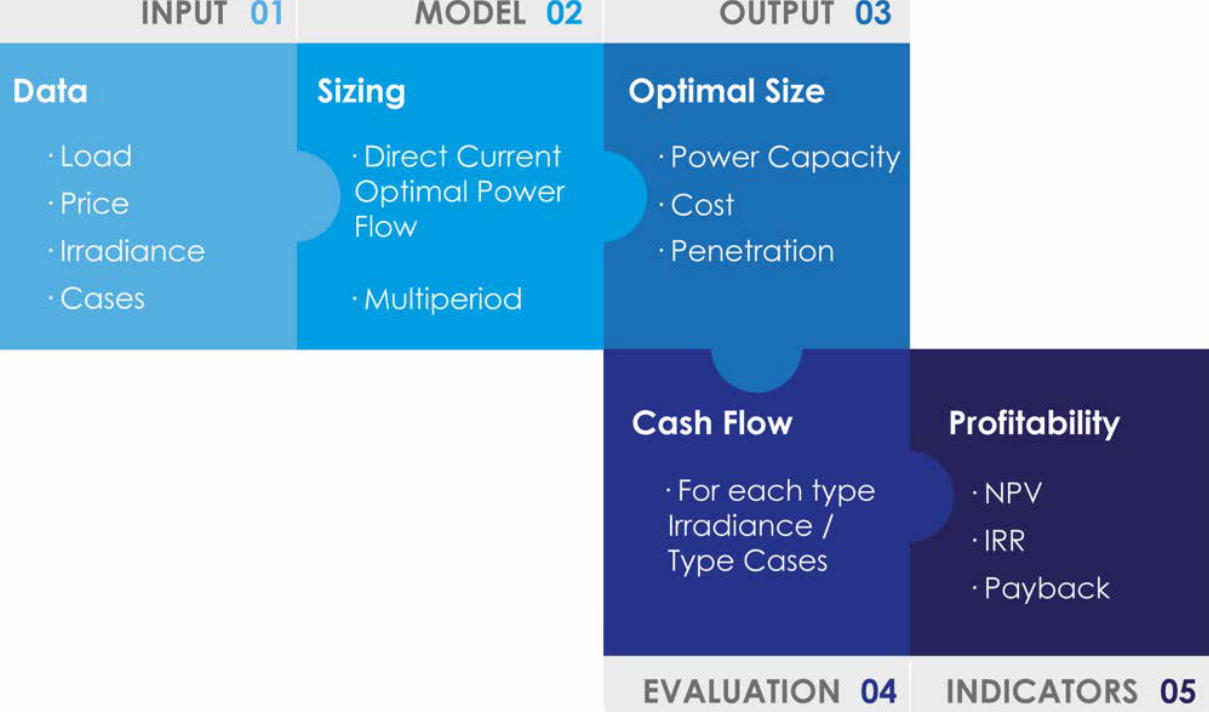
Figure 4. Methodological framework.